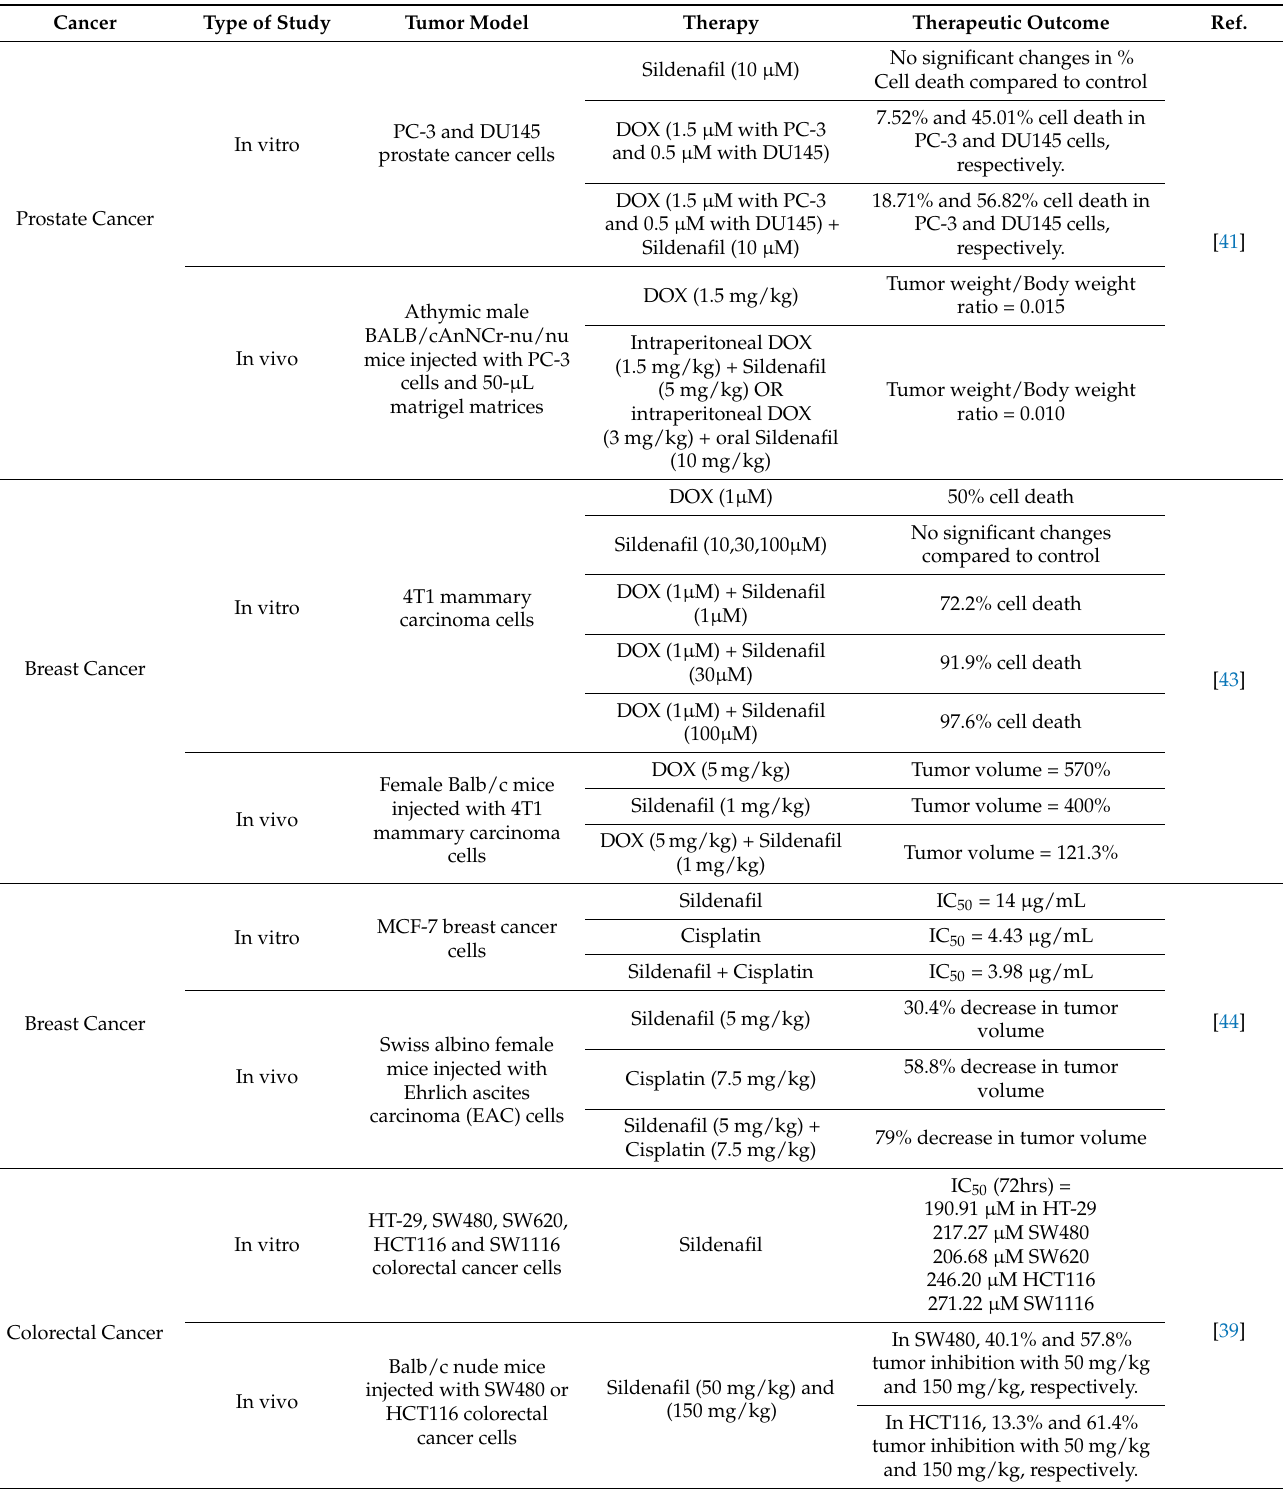
Table 1. Examples of in vitro and in vivo studies for the effect of sildenafil in different types of cancer.